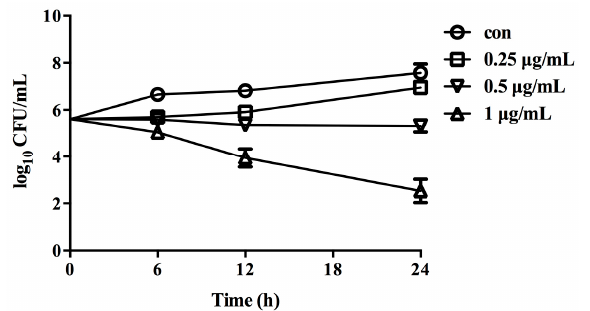
Figure 3. Time-killed curves for 16g against the C. albicans . The concentrations of 16g were adjusted to 0.25 µ g/mL (1 × MIC), 0.5 µ g/mL (2 × MIC), 1 µ g/mL (4 × MIC) in RPMI 1640 medium. con: control.